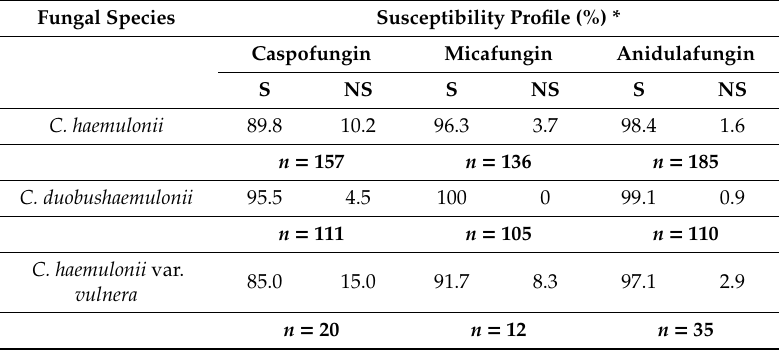
Table 3. Literature compilation regarding the distribution (%) of the susceptible (S) and non-susceptible (NS) isolates belonging to the C. haemulonii complex against echinocandins described in published papers available until 19 July